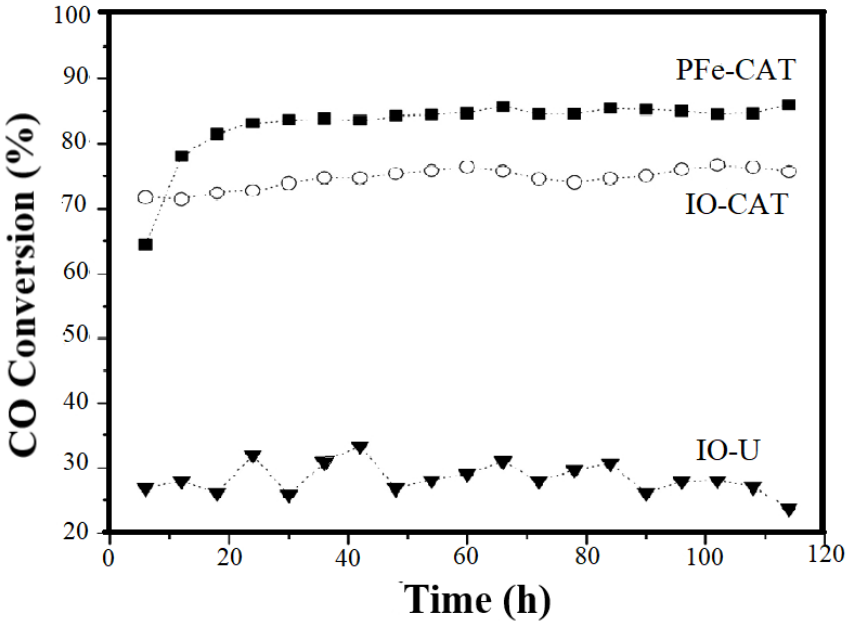
Figure 2. Comparison of CO conversation versus Time [6]. IO-U, IO-CAT, and PFe-CAT represented promoted iron ore after milling prior to calcination, promoted iron ore after calcination, and precipitated iron catalyst, respectively. Reproduced with permission from Elsevier. Table 3. FT catalytic performance of raw iron ore during LTFT conditions versus conventional iron catalysts.